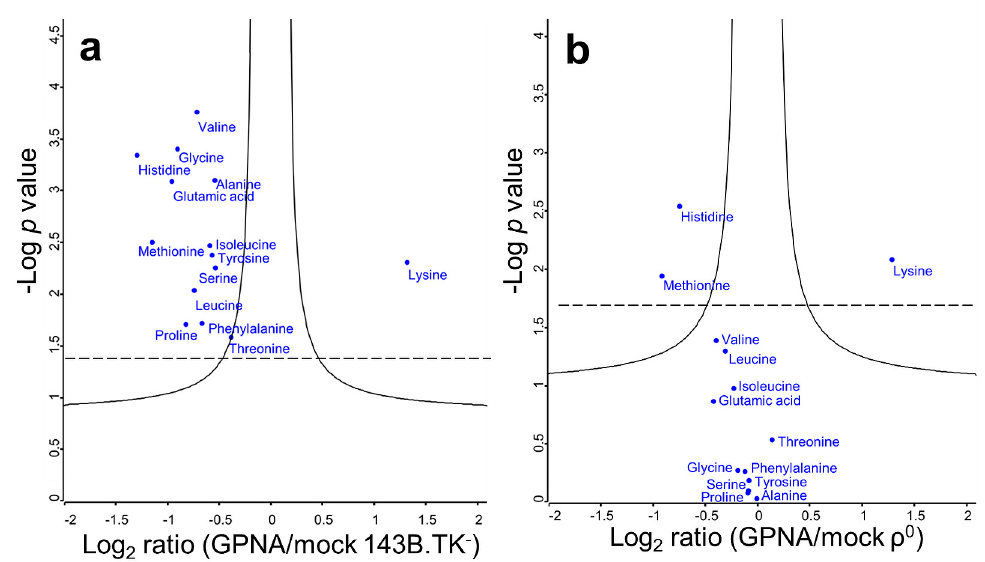
Figure 5. The SLC transporter inhibitor γ -glutamyl- p -nitroanilide (GPNA) significantly decreased the amount of almost all 13 C 15 N amino acids in ( a ) 143B.TK- cells, but had no effect on ( b ) ρ 0 cells. Significantly altered amino acids were above the continuous curve and in addition after Benjamini-Hochberg correction above the dashed line.